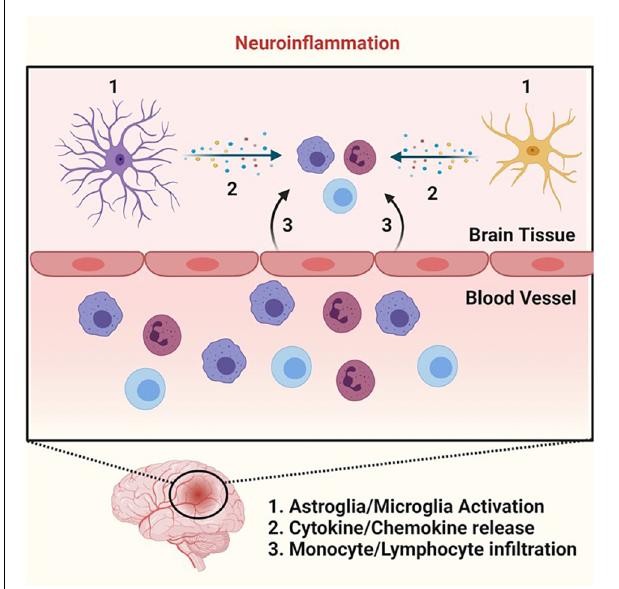
FIGURE 3 | Neuroinflammation. Cartoon summarizing the key events that lead to neuroinflammation. Neuroinflammation begins with microglia and astroglia activation (step 1) that stimulates the release of various cytokines and chemokines (step 2). The cytokine and chemokine production leads to the recruitment of monocytes and lymphocytes and their subsequent infiltration into the parenchyma (step 3), allowing these immune cells to perform their necessary functions in the process of neuroinflammation. Schematic representations were generated using Biorender (©BioRender -